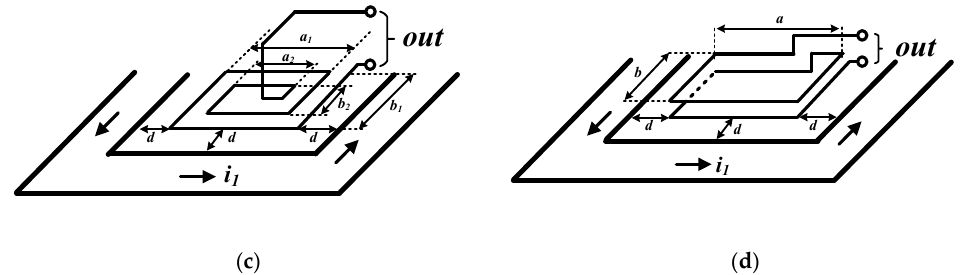
Figure 6. Geometry of the ( a ) model-1; ( b ) model-2; ( c ) model-3 and ( d ) model-4.